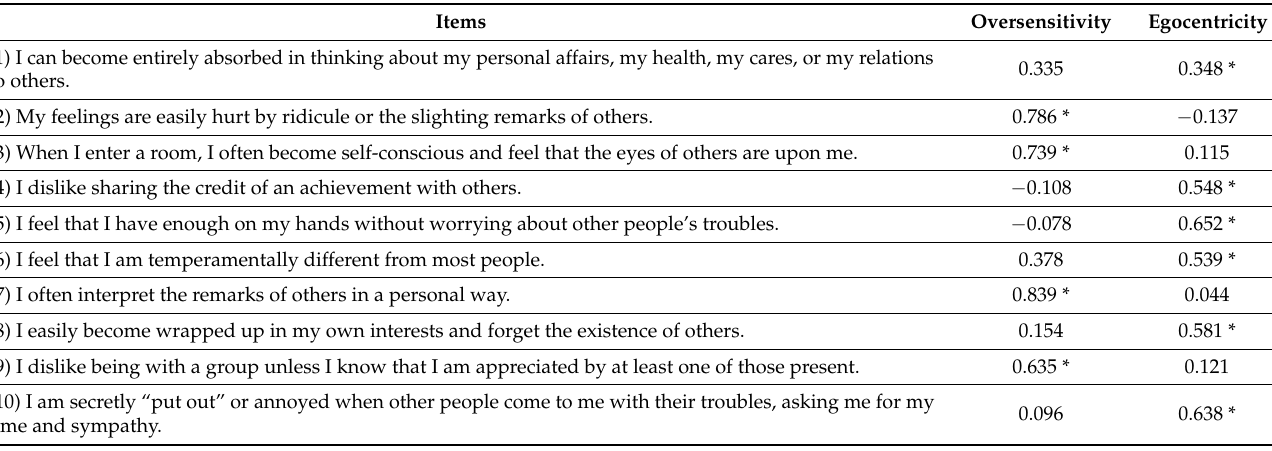
Table 1. Summary of HSNS factor loadings for oversensitivity and egocentricity. Items Oversensitivity